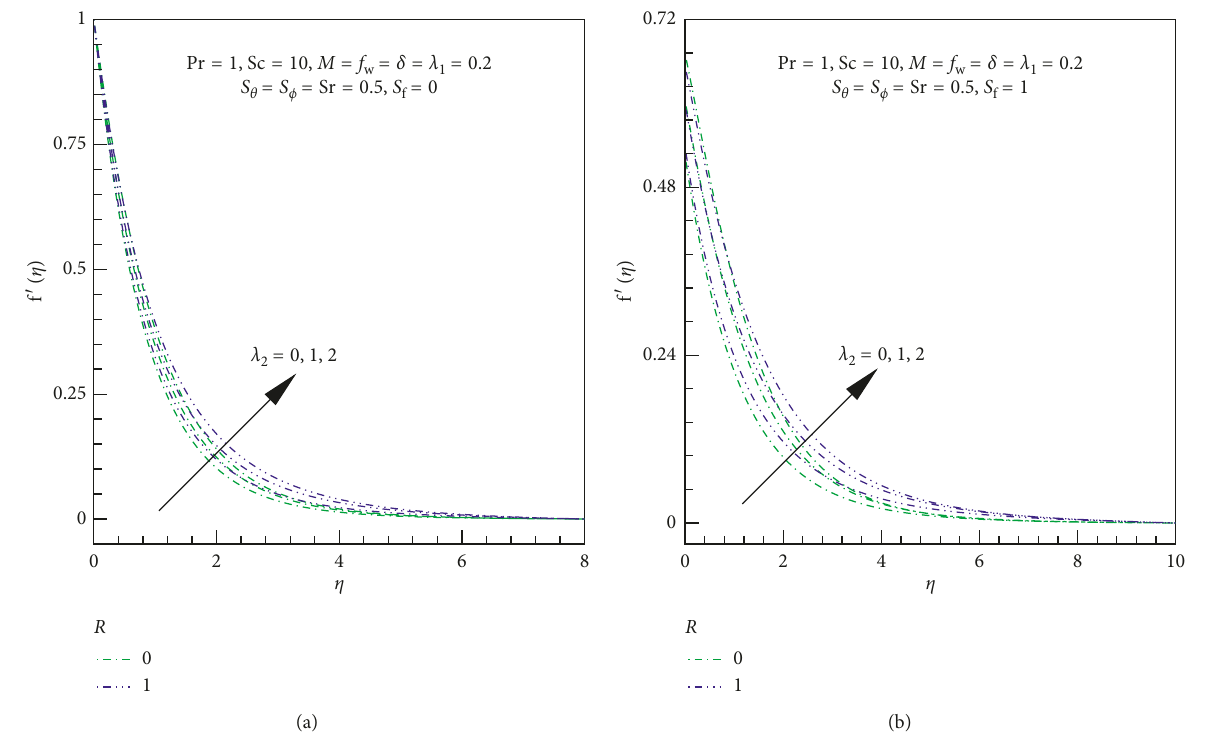
Figure 4: Effects of λ R on dimensionless velocity. (a) No hydrodynamic slip. (b) With hydrodynamic slip. 2 and